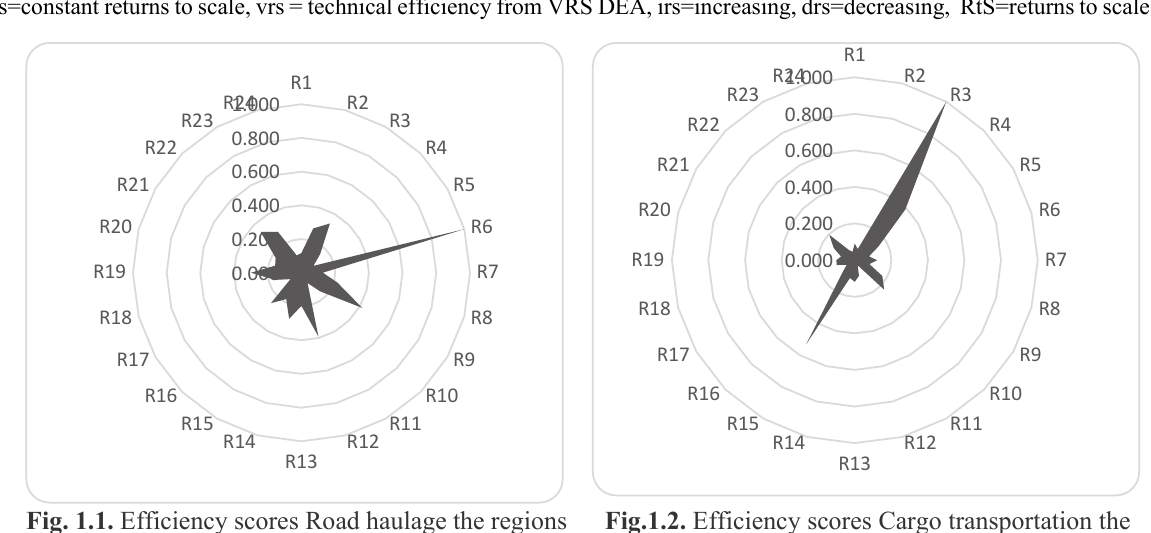
Fig. 1.1. Efficiency scores Road haulage the regions of Ukraine